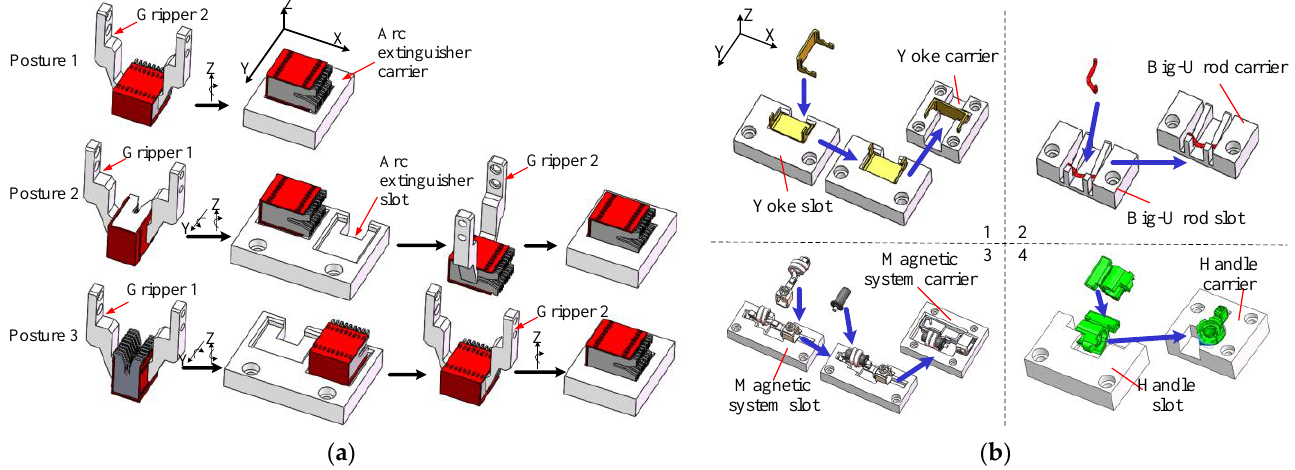
Figure 6. Flexible assembly processes for the parts: ( a ) arc extinguishing cover posture adjustment;